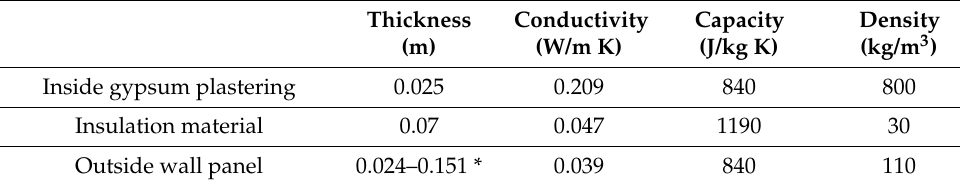
Table 2. Thickness and thermophysical properties of the wall.